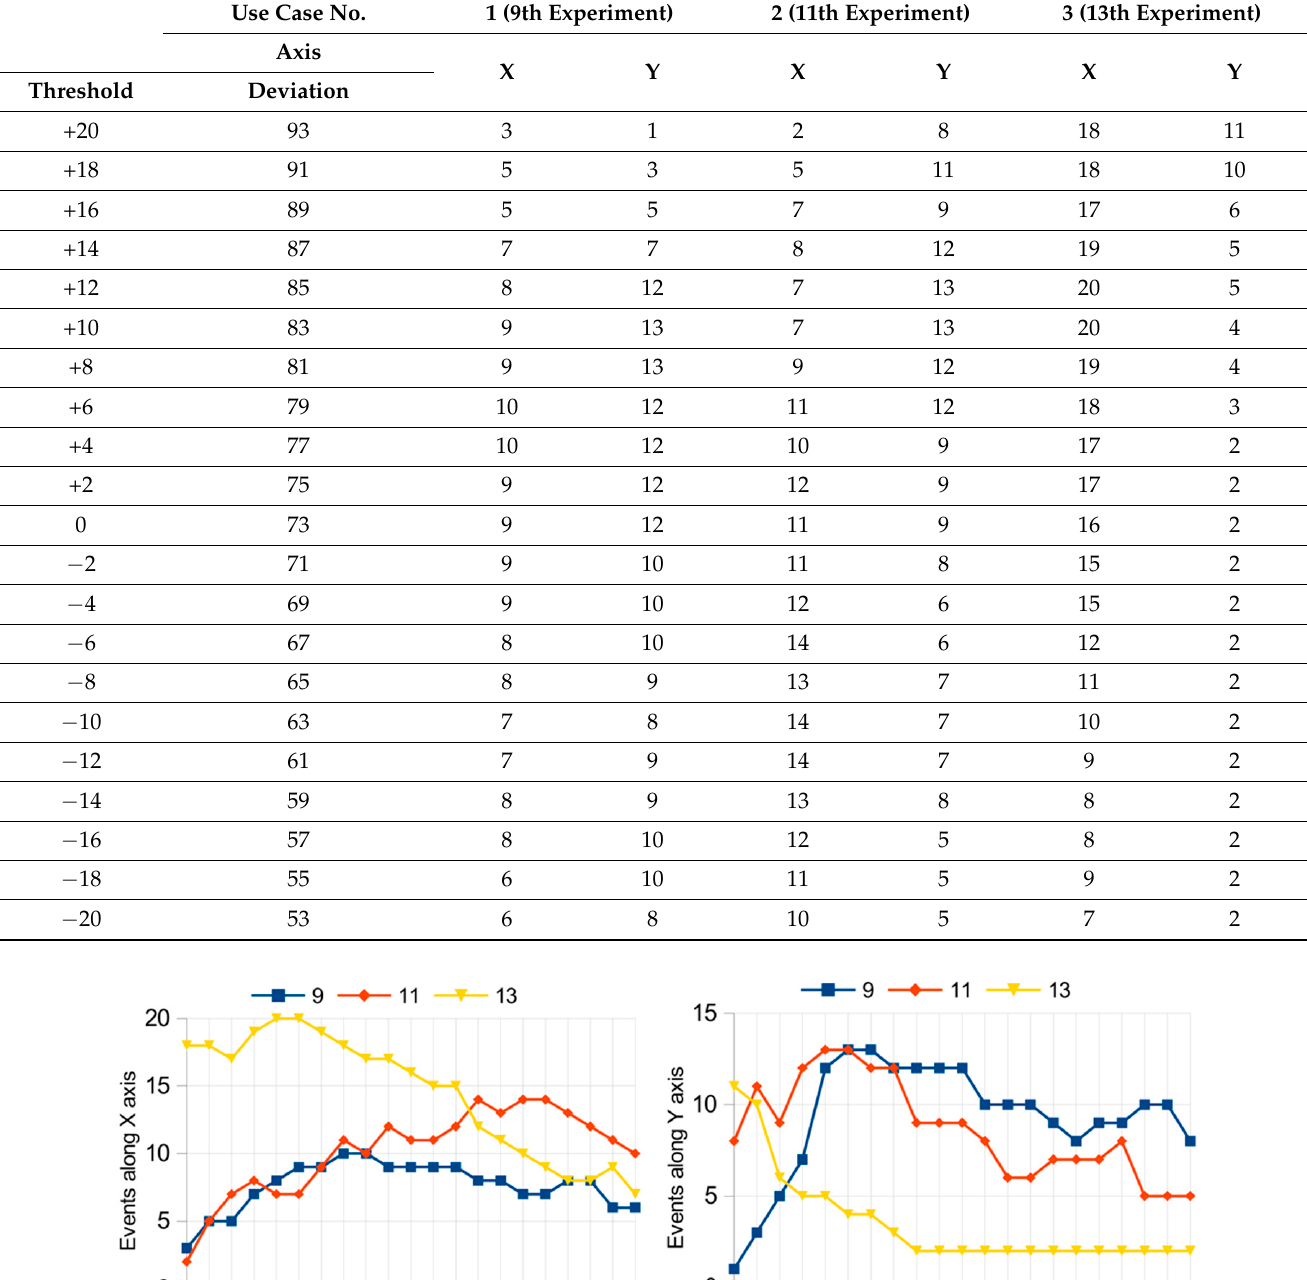
Table 1. Detection of impacts with varying levels of the threshold.